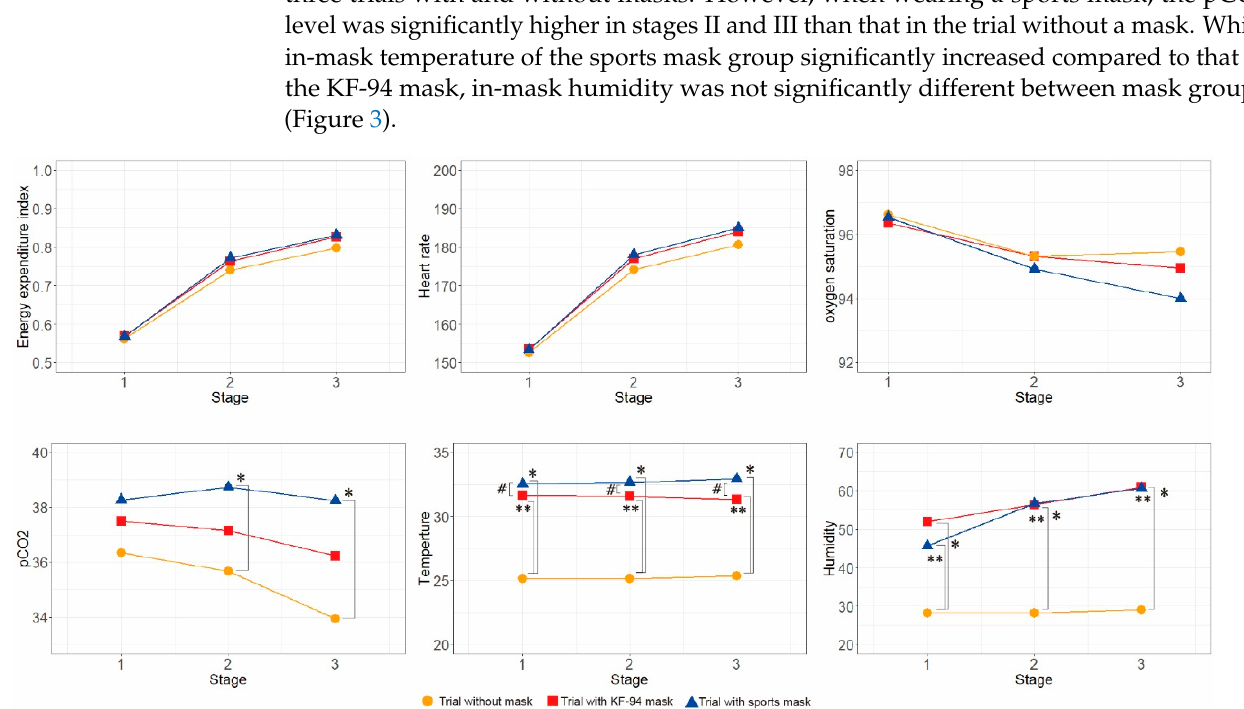
Table 2. Subjective ratings of discomfort during exercise in three conditions of wearing masks.